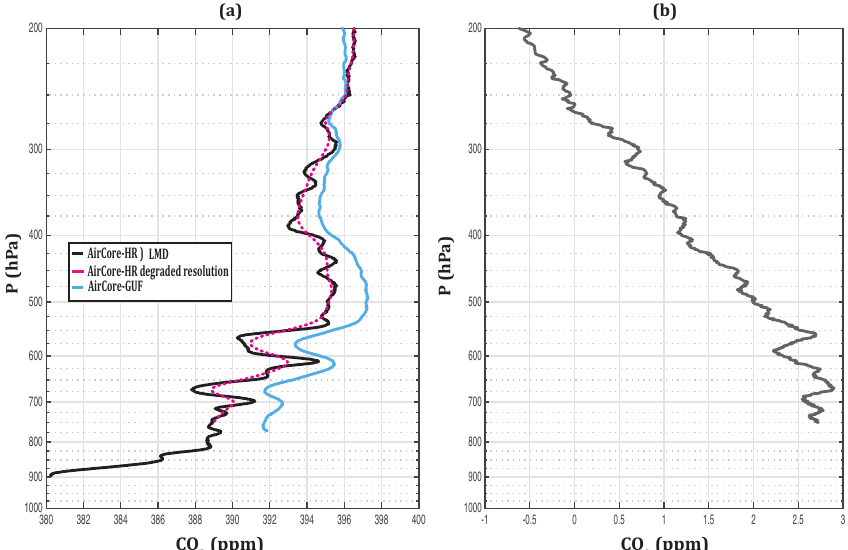
Figure 13. (a) CO 2 vertical profiles from AirCore-HR in full resolution (black), from AirCore-HR in “degraded resolution” (pink) and from AirCore-GUF (blue). (b) Residual of the difference AirCore-GUF − AirCore-HR in “degraded resolution”.